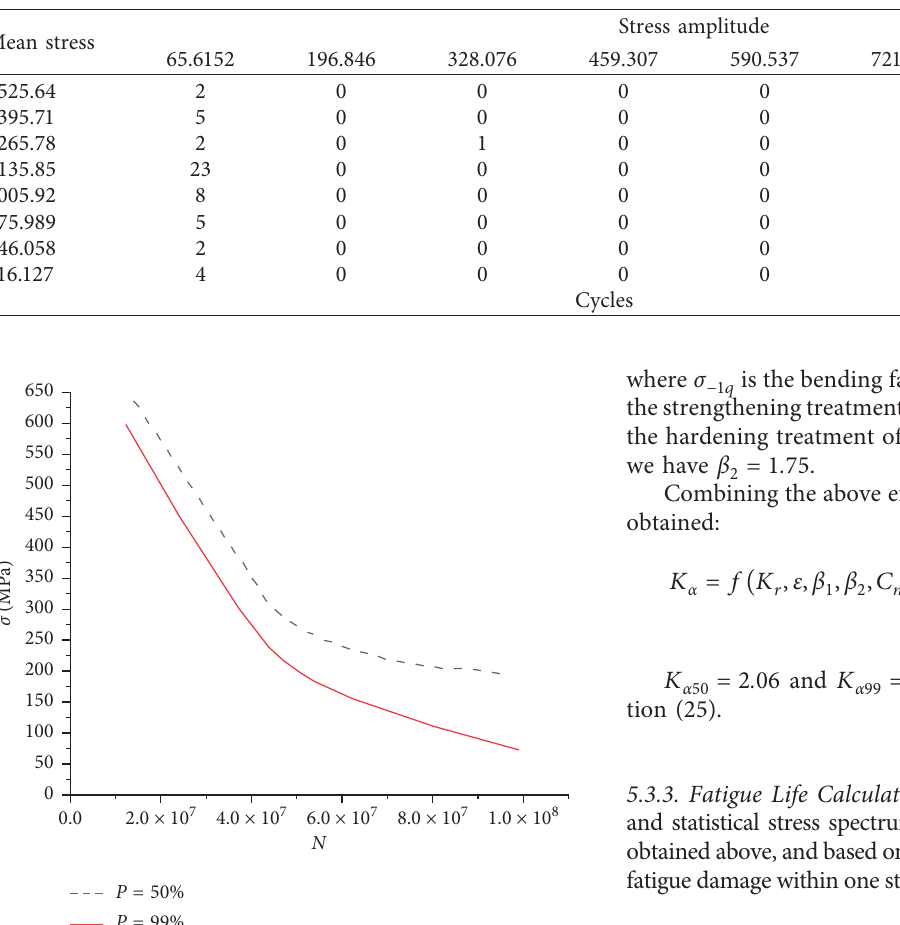
Table 6: Stress spectrum at point P3 of recoil spring (unit: MPa).